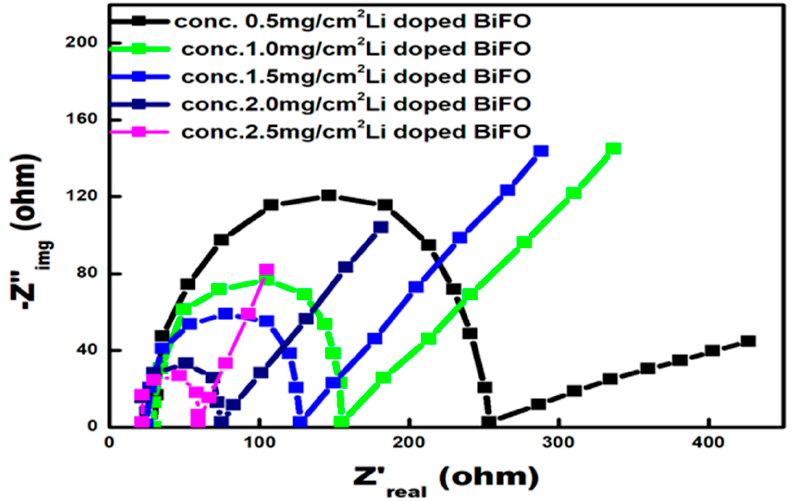
Figure 12. Nyquist plot of the MFC with different concentration of [BiFe 1 − x Li x O 3 ]-loaded graphene composite cathode concentrations.